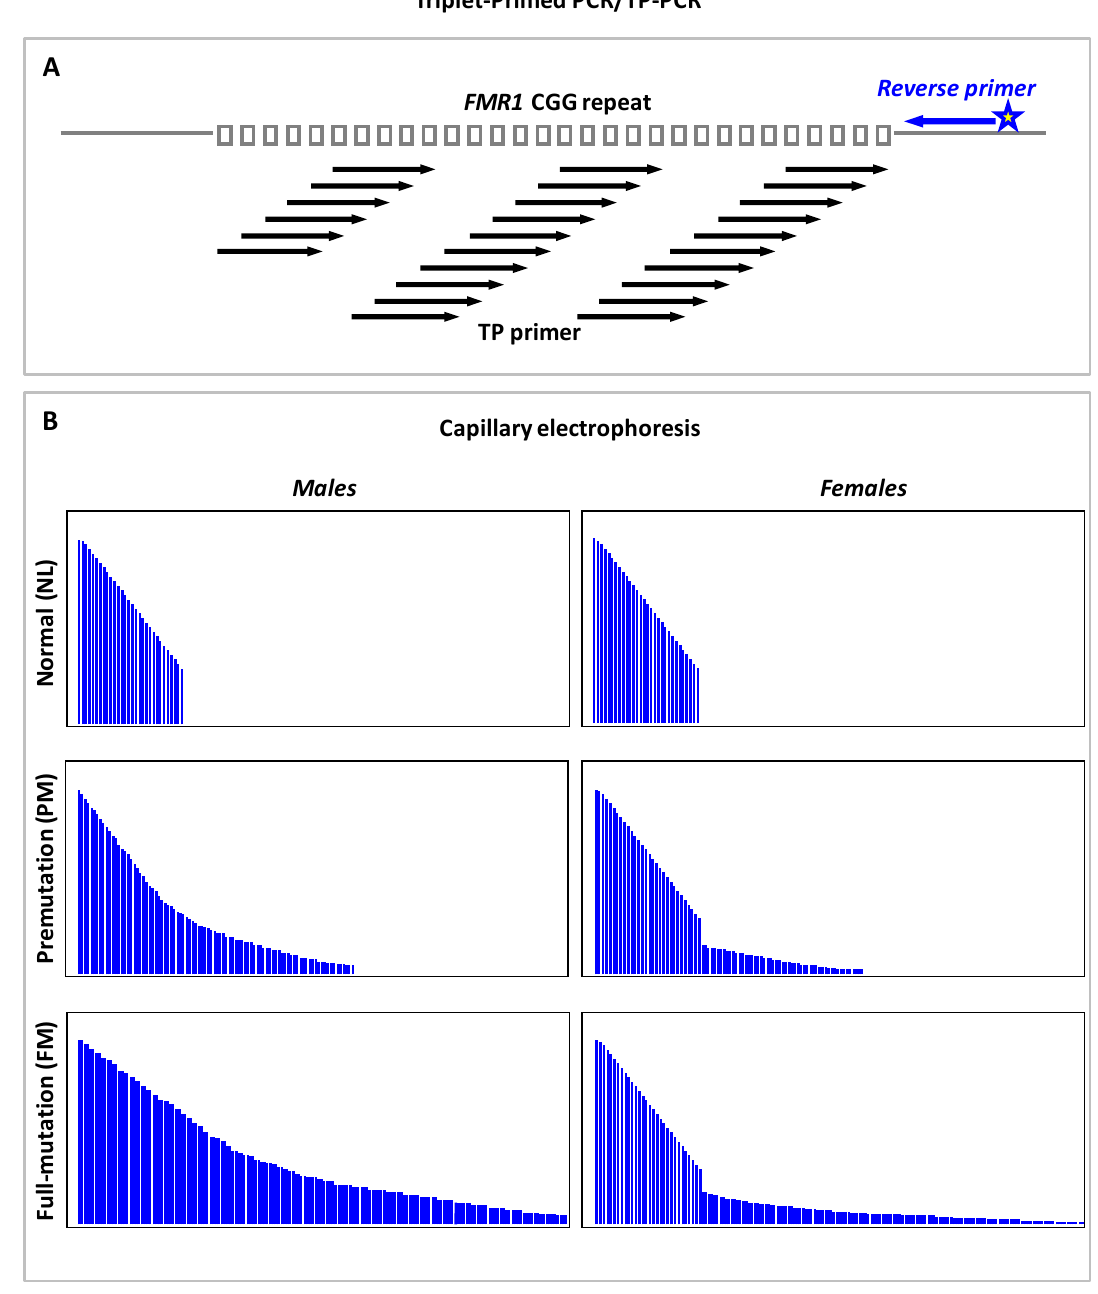
Figure 2. Triplet ‐ Primed PCR or TP ‐ PCR: ( A ) Schematic depicting the TP ‐ PCR primer design; and ( B ) Figure 2. Triplet-Primed PCR or TP-PCR: ( A ) Schematic depicting the TP-PCR primer design; and expected capillary electrophoresis profiles of normal, premutation and full ‐ mutation males and ( B ) expected capillary electrophoresis profiles of normal, premutation and full-mutation males and females. For simplification, the Tail primer is not shown. females. For simplification, the Tail primer is not